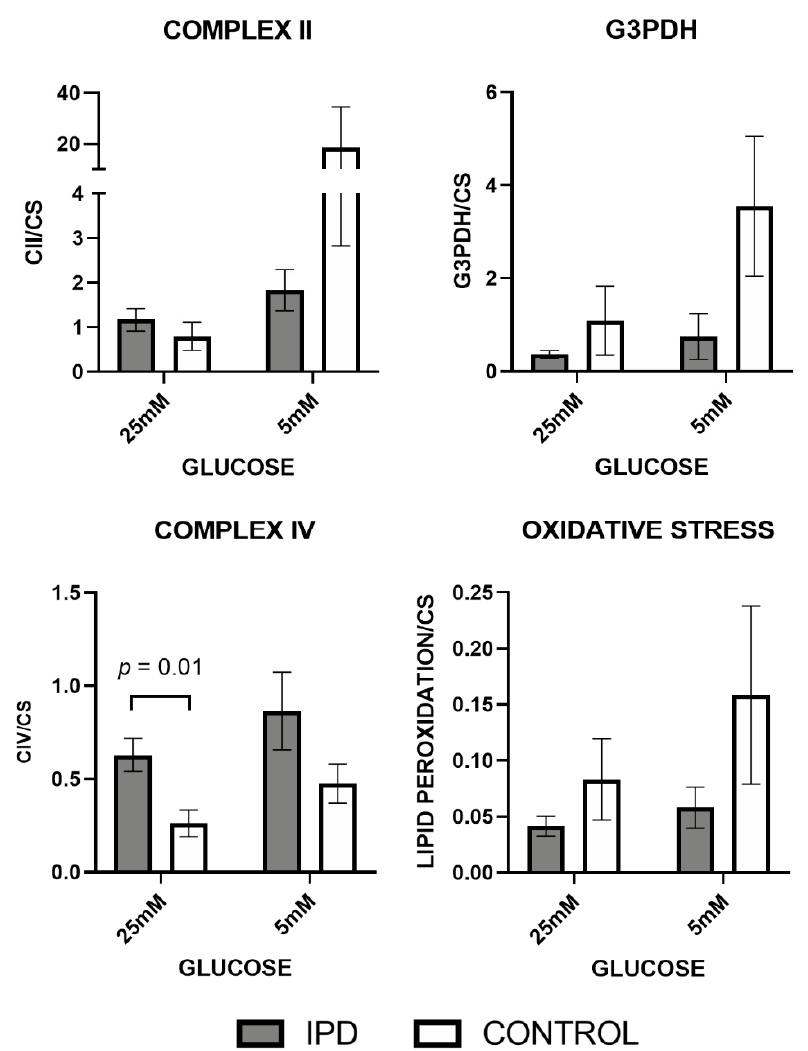
Figure 3. Mitochondrial enzymatic and oxidative stress levels in fibroblasts of iPD patients vs. controls exposed to low or high glucose concentration (5 vs. 25 mM). Mitochondrial respiratory chain (MRC) enzymatic activities were decreased in fibroblasts from idiopathic Parkinson’s disease patients (iPD, gray bars) vs. controls (C, white bars) except for Complex IV (CIV) activity, which trended to increase in iPD fibroblasts, significantly when exposed to high glucose ( p = 0.01), probably to overcome Complex II (CII)-glycerol-3-phosphate dehydrogenase (G3PDH) impairment. As a result of CII-G3PDH MRC reduction in iPD-fibroblasts, oxidative stress levels, as a secondary product of MRC function, trended to decrease in iPD-patients. In high glucose fibroblasts of iPD patients showed decreased metabolic plasticity than controls to adapt to di ff erent glucose conditions. CS, citrate